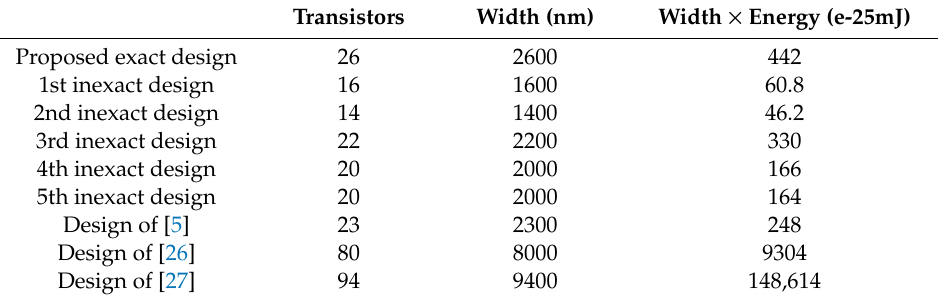
Table 6. Area and Energy